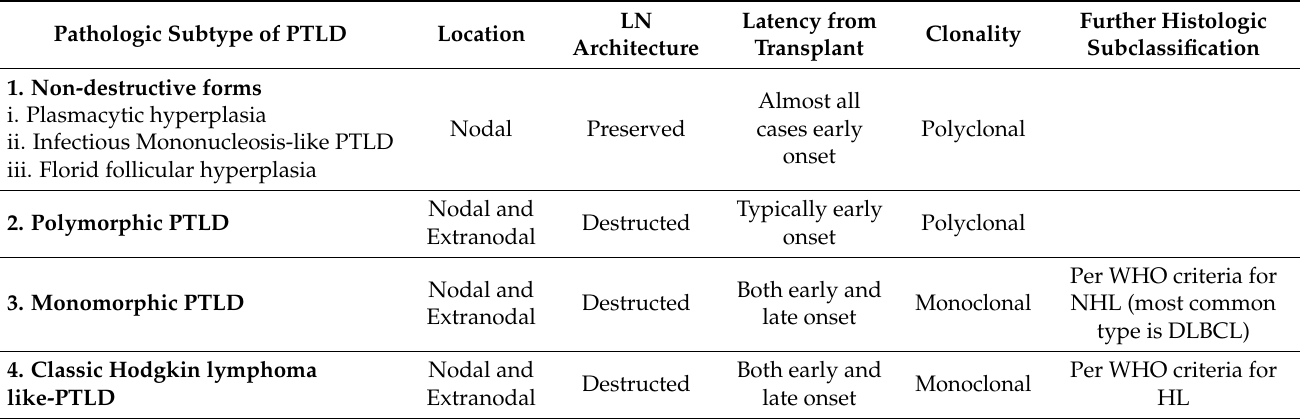
Table 1. Pathologic World Health Organization classification of